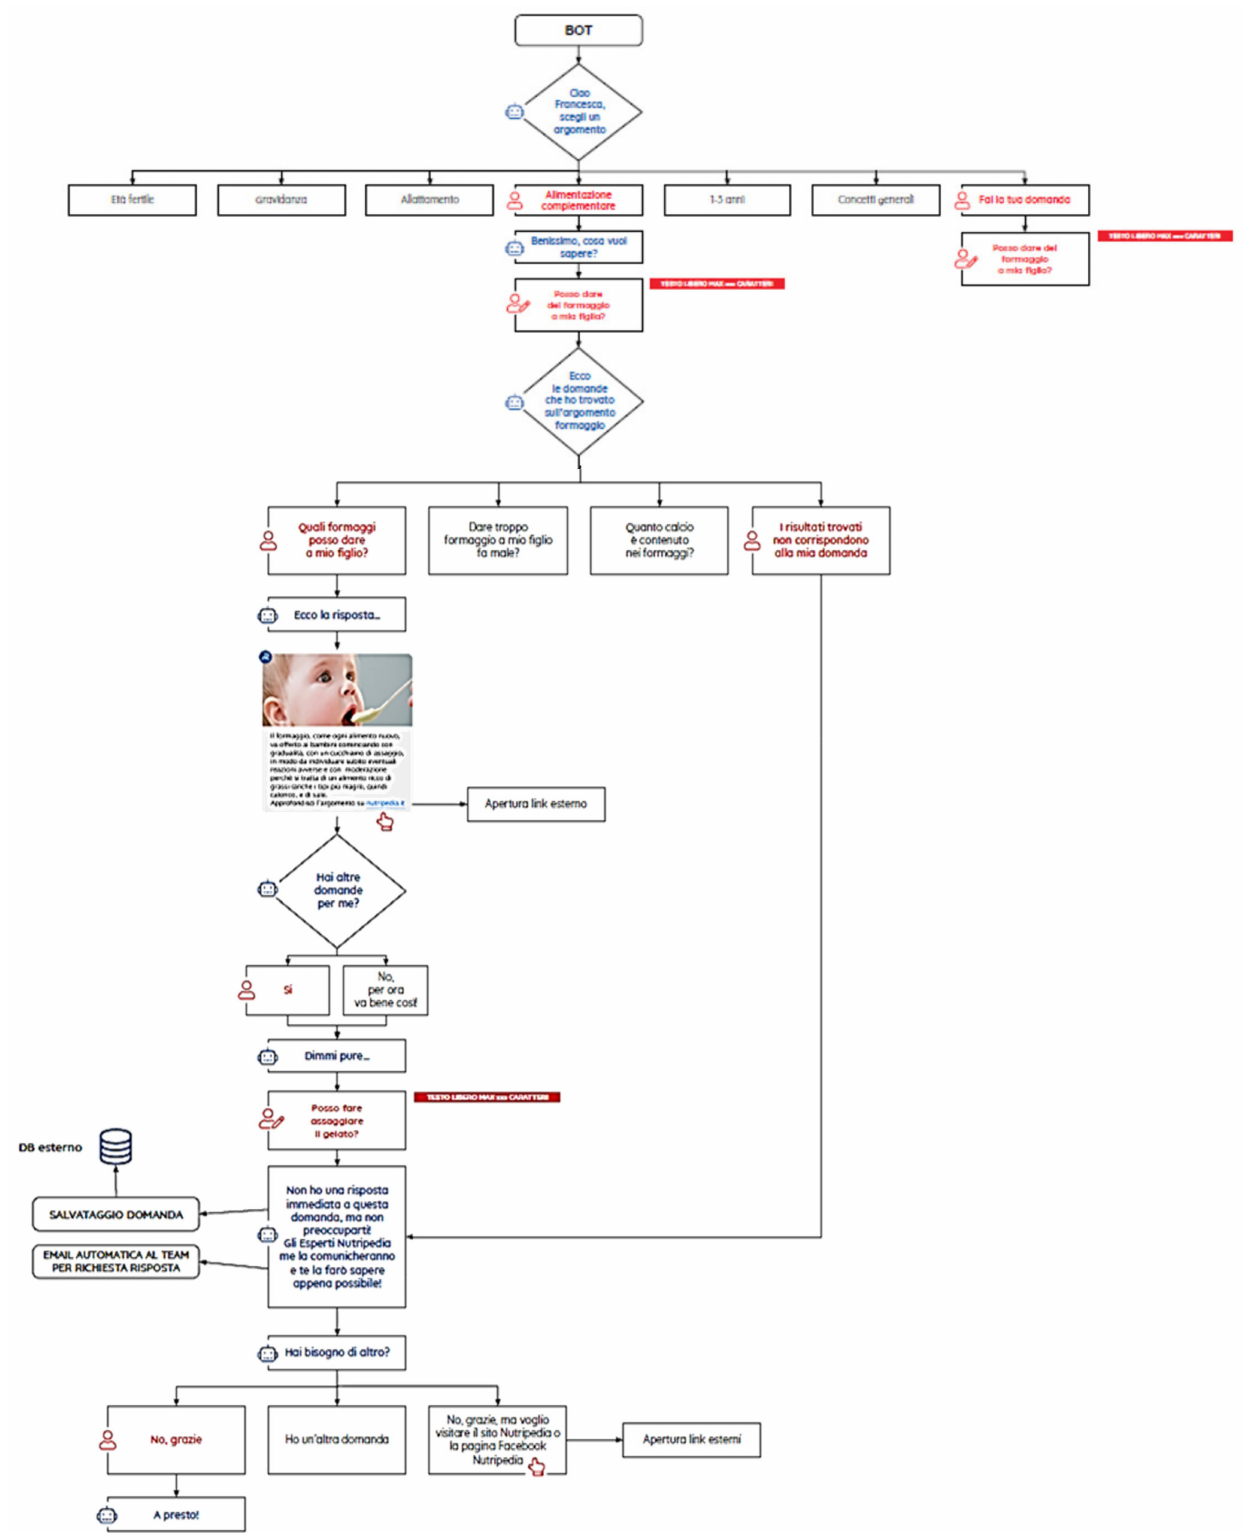
Figure 6. Simulation of questions functionality of the Nutripedia-Chatbot app. An example: having asked if during complementary feeding cheese is allowed for infants, the BOT presents the user 4 topics: “Which type of cheese is permitted”, “Too much cheese is dangerous?”, “Calcium content in cheeses” and “No results found”. Concerning to each topic, the BOT answer is a link to the specific article concerning to it. Following this, if BOT is asked something not registered in the app, the question is collected, and an automatic email is sent to Nutripedia Expert Team to answer